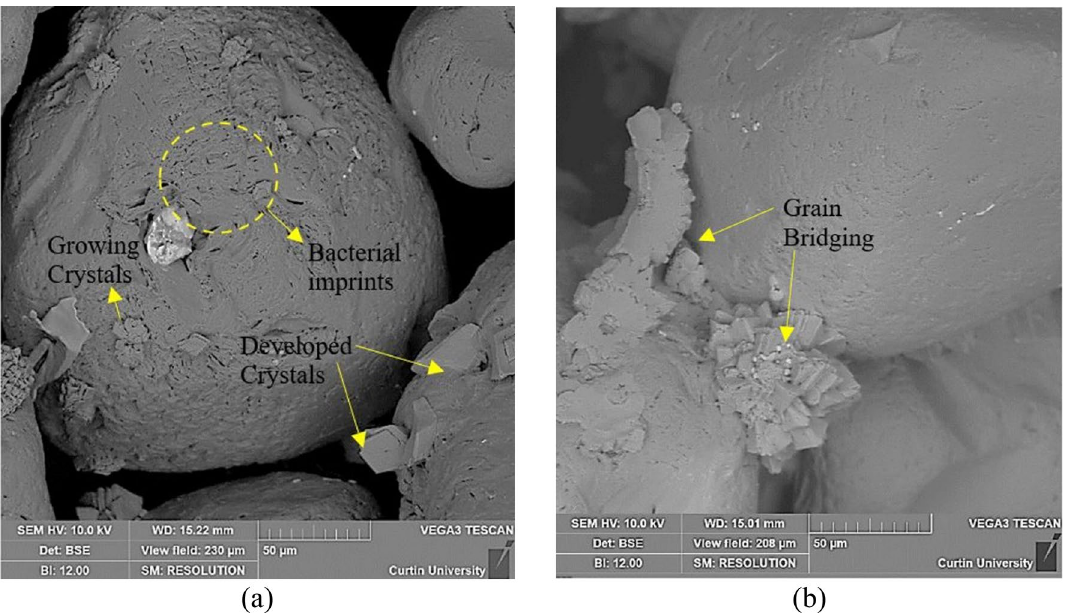
Figure 8. FESEM images of the treated sand grains ( a ). Calcite crystal growing on the sand grains on BS3- BC1 sample ( b ). Calcite bridging in BS3-BC3